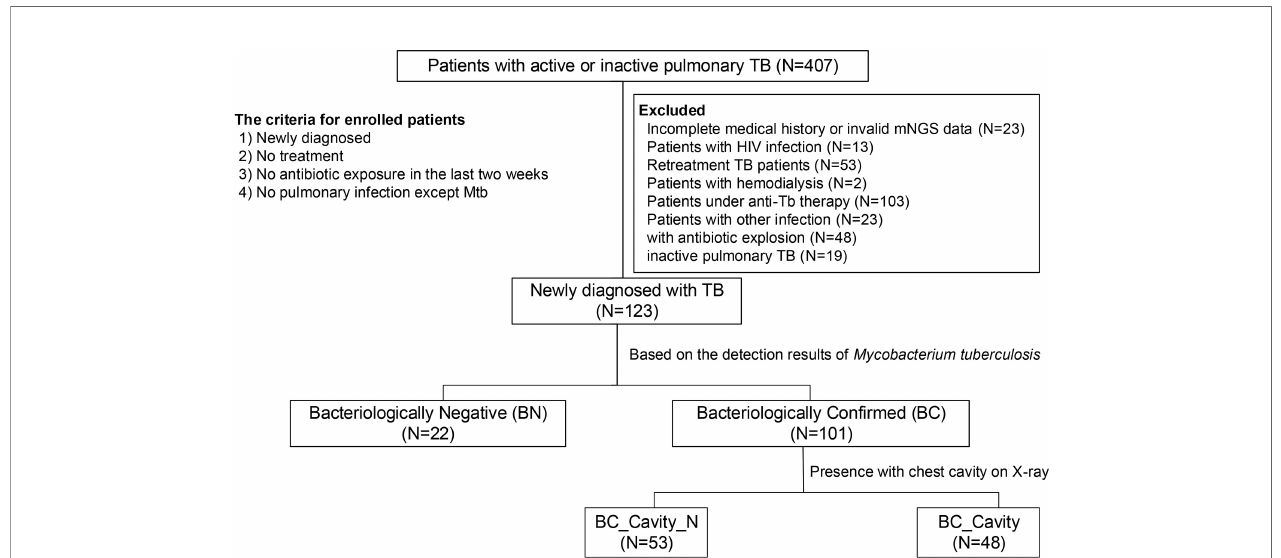
FIGURE 1 | Criteria for the enrollment of TB patients in the present study. From a total of 407 diagnosed patients, 123 patients were included in this study. Enrollment criteria included 1) new diagnosis, 2) no treatment, 3) no antibiotic exposure in the last two weeks, and 4) no other pulmonary infection except tuberculosis. The enrolled patients were divided into two groups, bacteriologically con fi rmed (or BC, N = 101) and bacteriologically negative (or BN, N = 22), based on an improved method in which we combined traditional culture-based approach with mNGS. BC patients were further categorized as BC_Cavity (N = 48) and BC_Cavity_N (N = 53) based on the presence of cavity on the chest